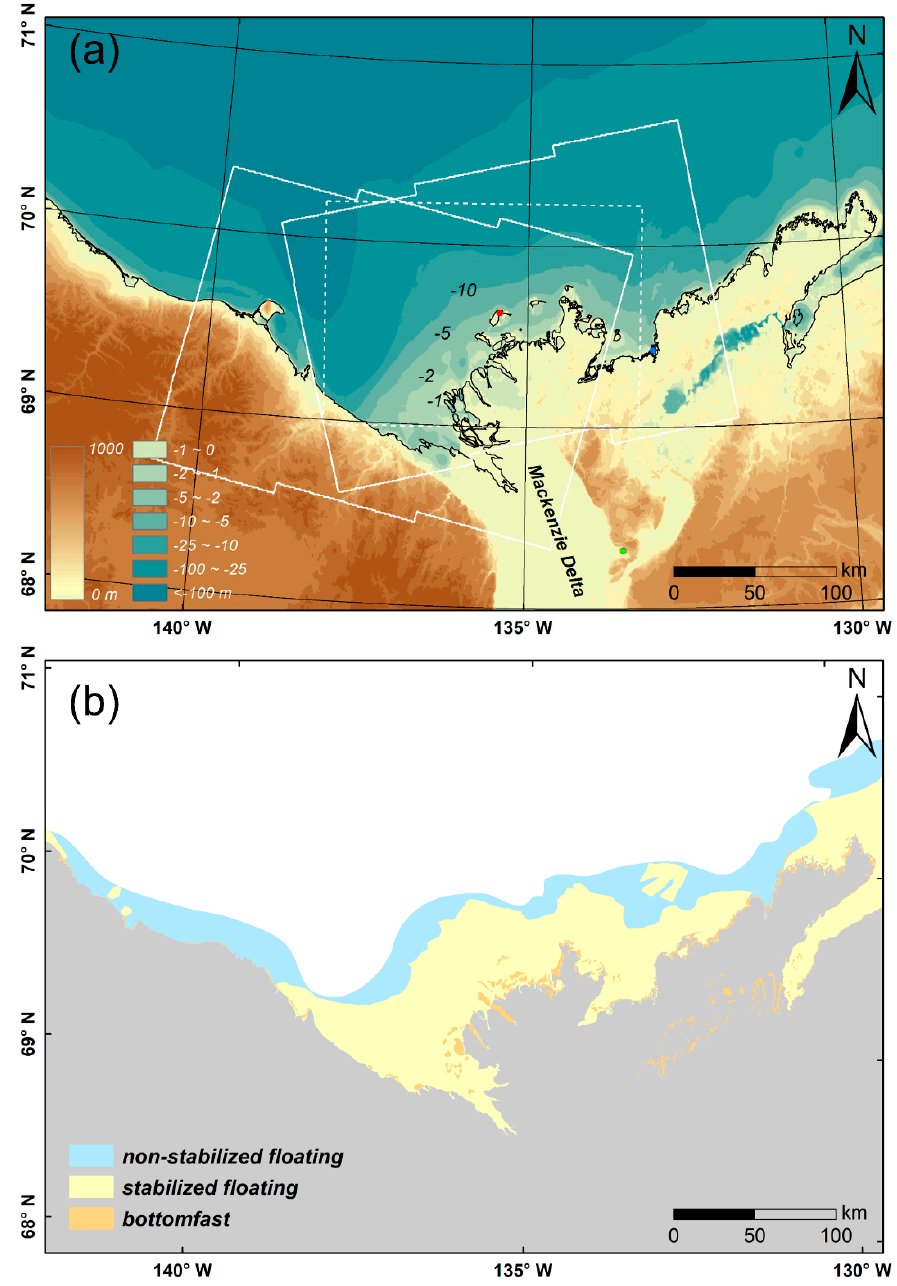
Figure 1. Digital elevation model of the Mackenzie Delta ( a ) and InSAR-derived landfast ice map modified from Dammann et al. (2019) ( b , Land is masked out in grey). The solid white lines are Sentinel-1 ascending and descending coverages used in this study. The dashed white rectangle represents the coverage of Sentinel-1 and Landsat 8 subsets in Figures 3 and 4. The red, green, and blue dots mark the Pelly Island, Inuvik, and Tuktoyaktuk stations, respectively. The DEM was modified from the coastal digital elevation model global mosaic provided by National Oceanic and Atmospheric Administration (NOAA)/National Centers for Environmental Information (NCEI). The 3D SPO in Figure 5 was performed for the overlapped part of ascending and descending